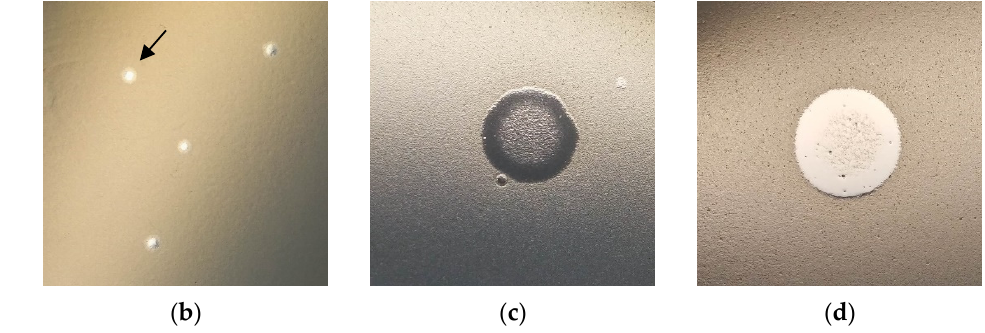
Figure 1. Ps15 plaque morphology on: ( a ) TSA with calcium chloride; ( b ) TSA without calcium chloride (the arrow points to a halo); ( c ) 10 µL spot on S. maltophilia Smal2; ( d ) 10 µL spot on S. maltophilia Smal17.